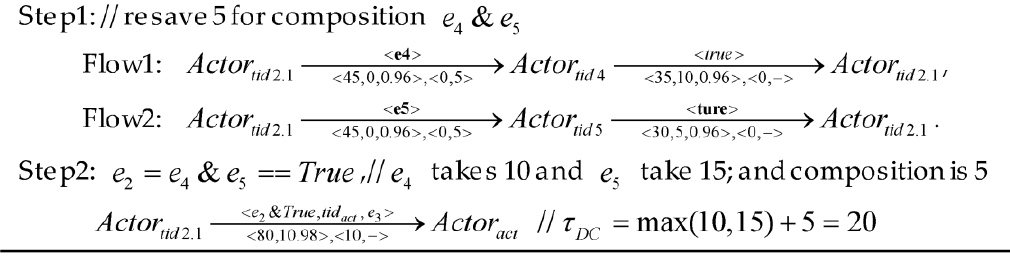
Figure A3. The example flow of decomposition.